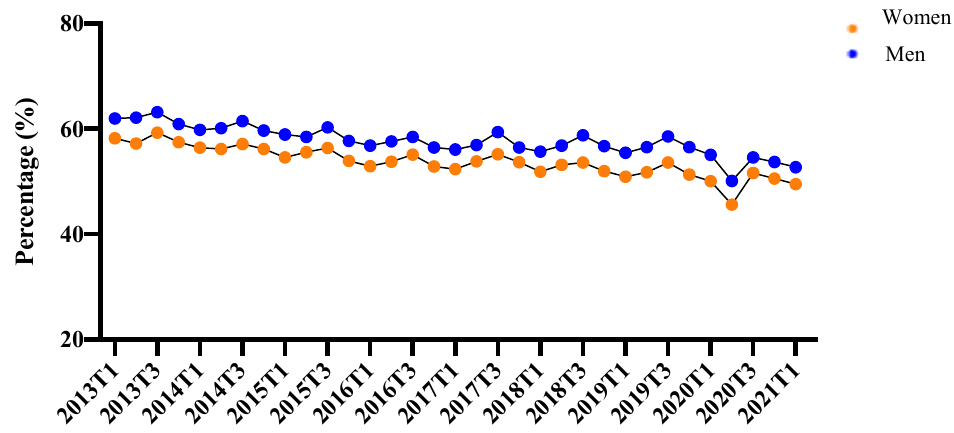
Figure 9. Activity rate by terms, Spain 2013–1st trimester of 2021. Source: Our own elaboration through EPA microdata.